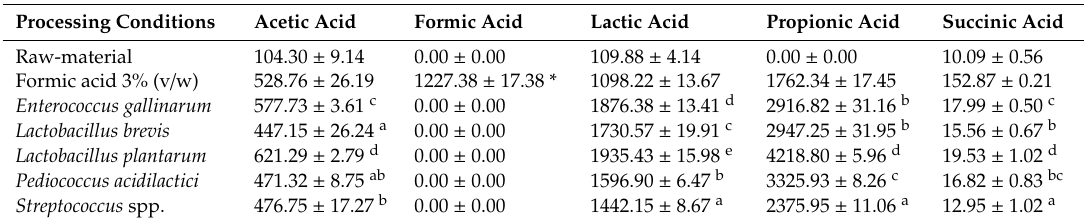
Table 4. Yields (mean value ± standard deviation, expressed in mg organic acid / 100 g sample ) ( n = 3) of organic acids in acidified and fermented wet gibel carp ( Caracius gibelio ) silages of 3 weeks. In the fish silages, the acidic conditions were obtained by adding formic acid 3% (v / w), whereas the fermentation were carried out by independent inoculations with pure cultures of distinct lactic acid bacteria (LAB).